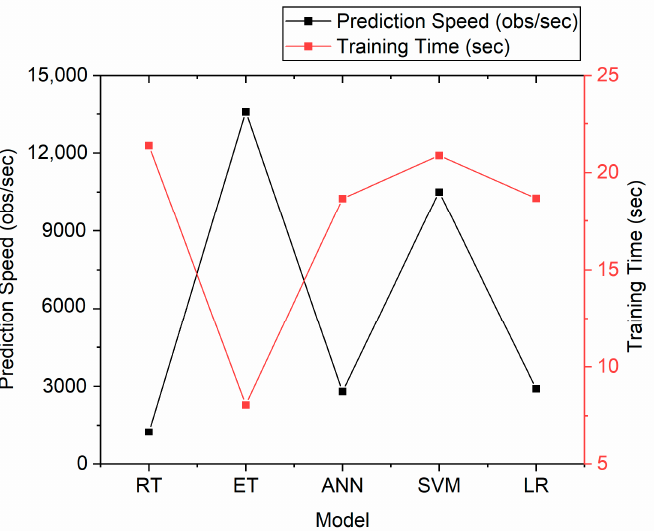
Figure 5. Comparison of the prediction speed and training time for the best model within different ML approaches (RT, ET, ANN, and SVM) and linear regression (LR).